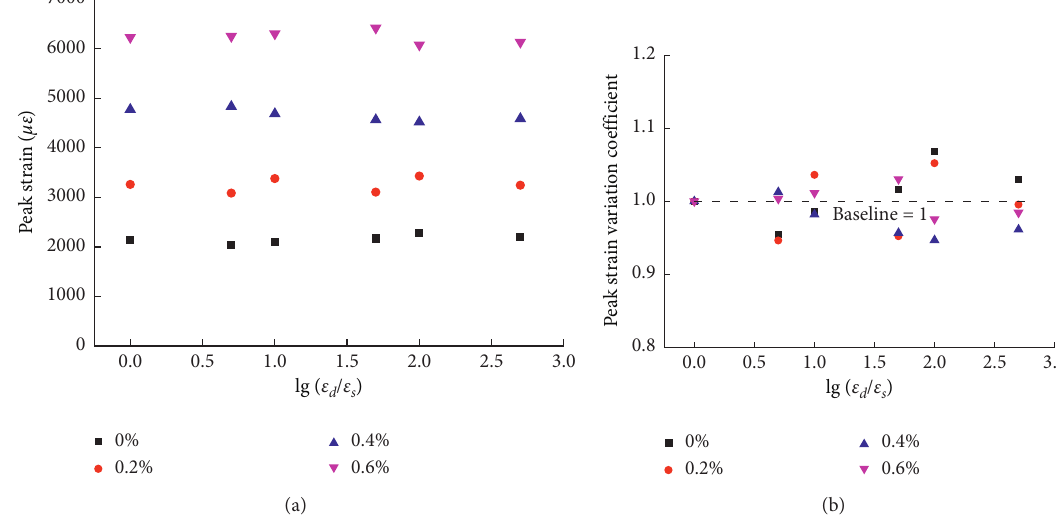
Figure 10: Peak compressive strain of polypropylene fiber reinforced concrete under different loading conditions. (a) Compressive peak strain. (b) Peak compressive strain variation